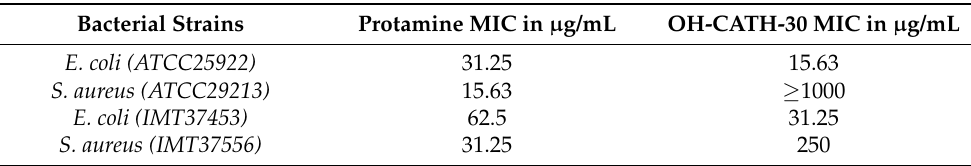
Table 4. Results of AMP minimum inhibitory concentration (MIC) experiments. Results determined in at least three independent